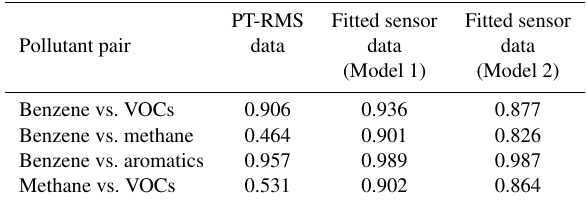
Table 4. Coefficient of determination ( R ) between reference data pairs and fitted sensor data